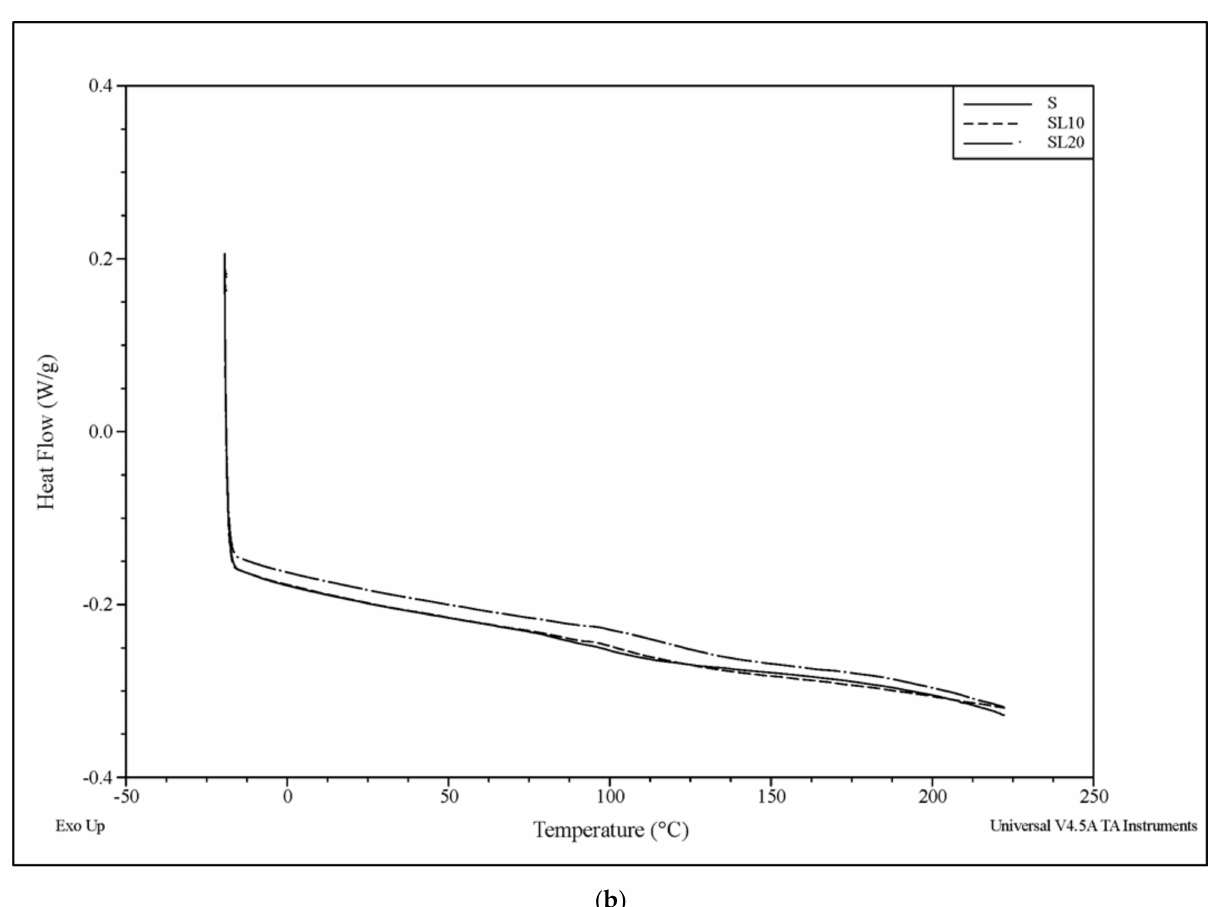
Figure 6. ( a ). Differential scanning calorimetry curves from first heating cycle of neat starch and starch–lignin composite with a different number of super grinding cycles. ( b ) Differential scanning calorimetry curves from second heating cycle of neat starch and starch–lignin composite with a different number of super grinding